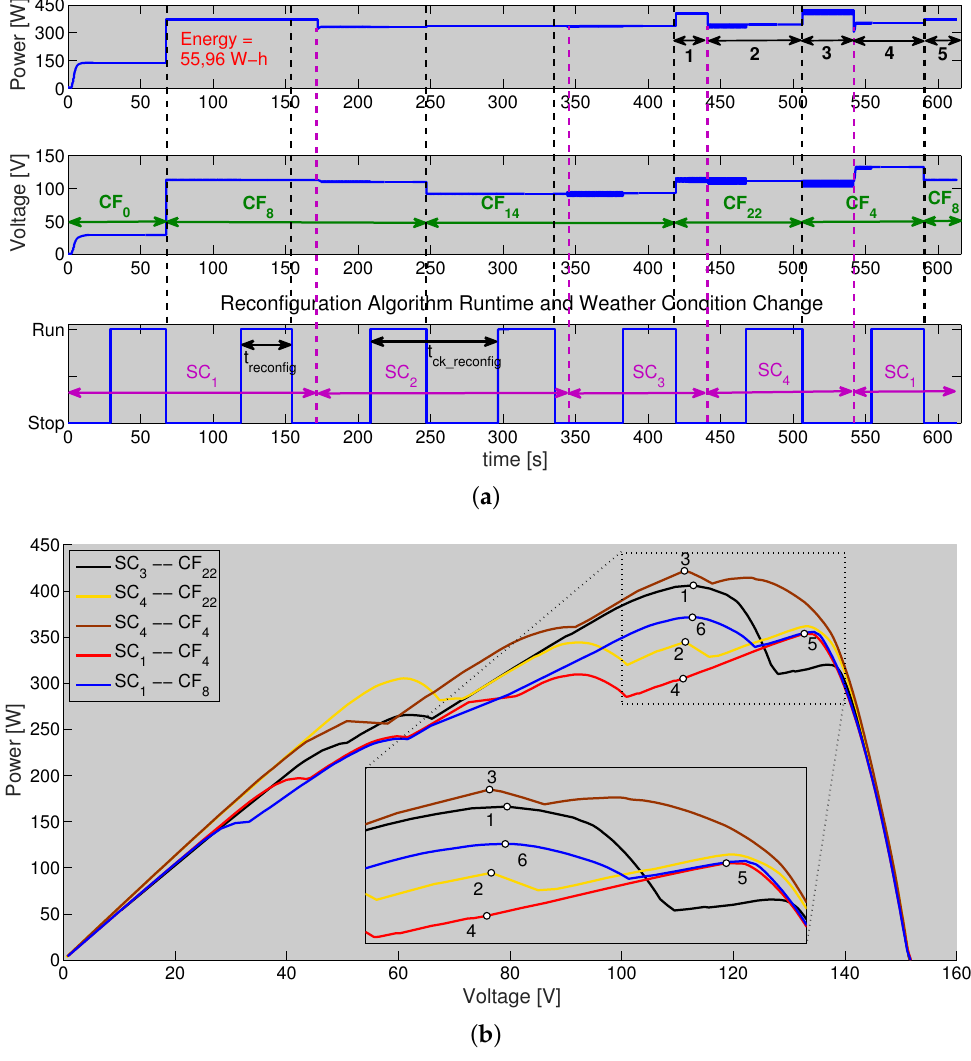
Figure 12. Behavior of the PV array with the proposed reconfiguration algorithm. ( a ) Dynamic behavior of PV array power, voltage and reconfiguration algorithm runtime; ( b ) Operating points in the P-V curves from 430